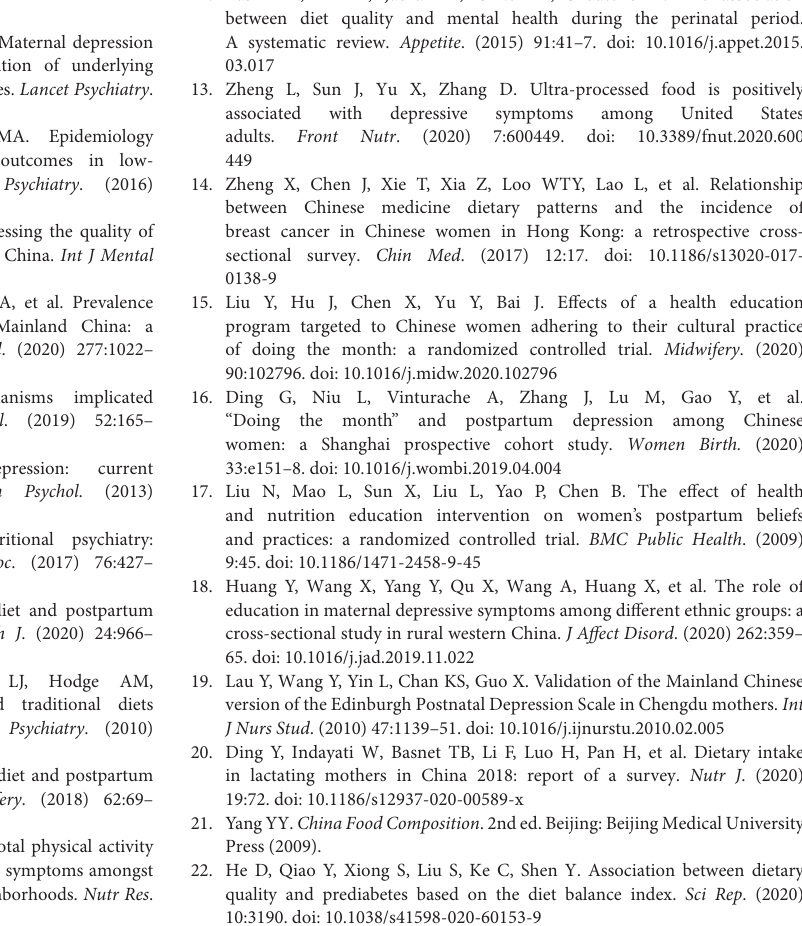
Supplementary Table 1 | The DBI calculating methods in this